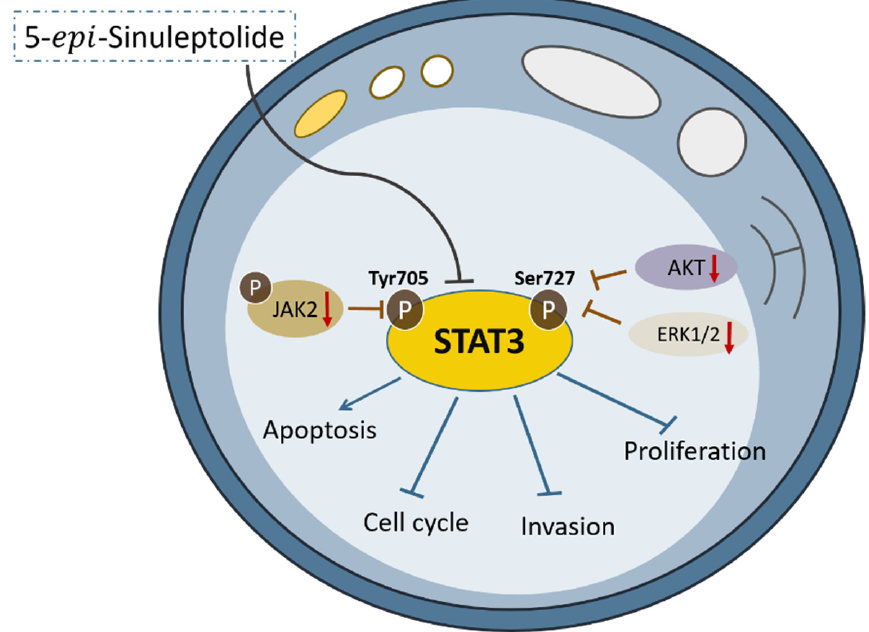
Figure 6. Schematic illustration of the mechanism of the cytotoxic effects of 5-epi- sinuleptolide on pancreatic cancer cells.